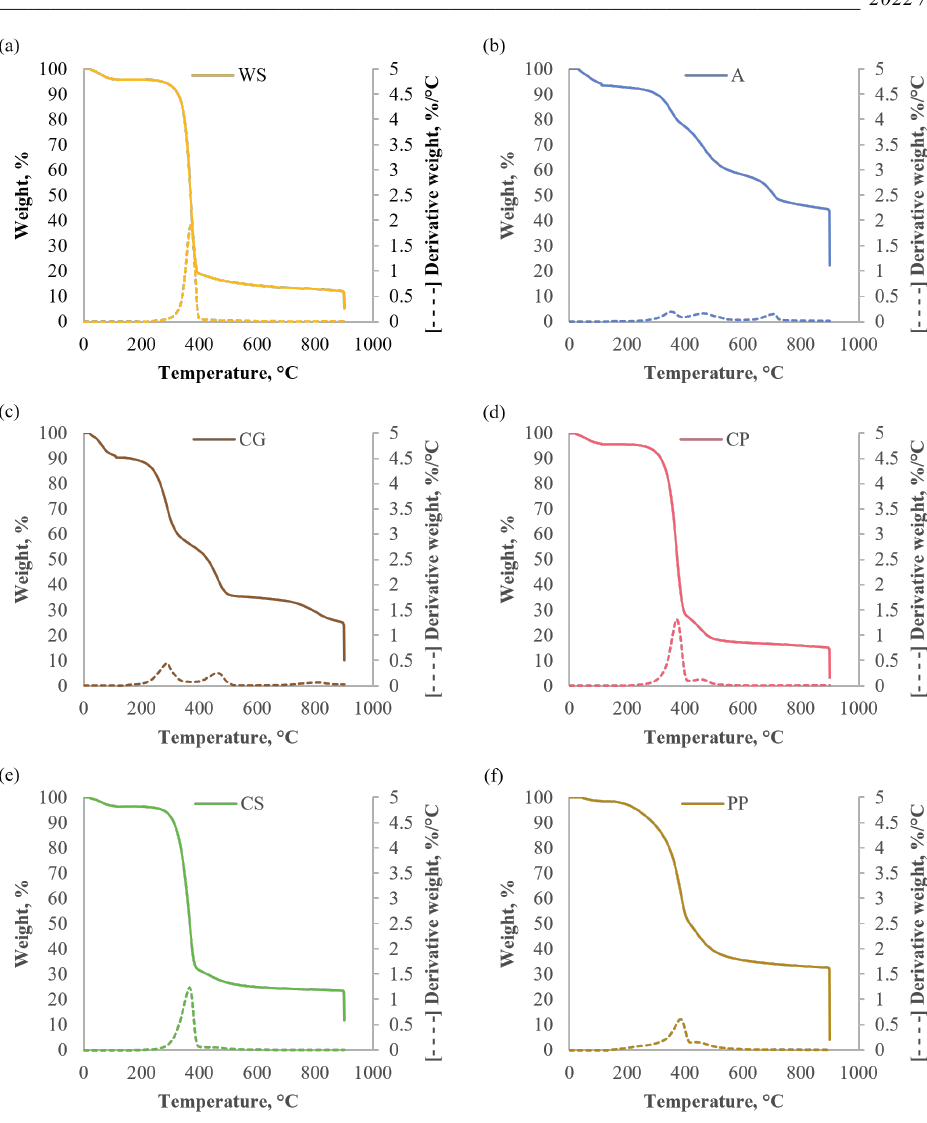
Fig. 8. Thermogravimetric analysis of hydrochars obtained during hydrothermal carbonization process in alkaline environment (24 h, 200